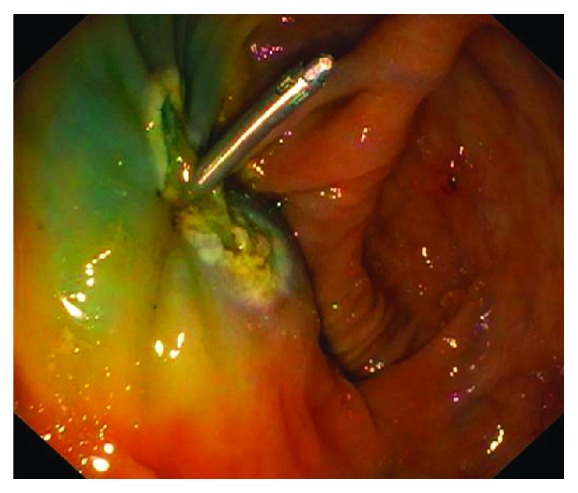
Colonoscopic finding. No definite perforation is seen. Hemostatic clipping and hot biopsy coagulation near the ileocecal valve were done.